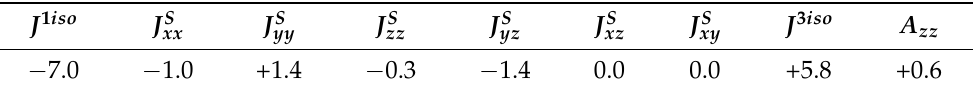
Table 1. Magnetic exchange coupling parameters and single-ion anisotropy, in terms of energy units (meV), for the NiI 2 monolayer. In the adopted convention, negative (positive) values of the exchange parameters refer to FM (AFM) magnetic interaction, while the positive (negative) value of SIA ( A zz ) indicates easy-plane (easy-axis)